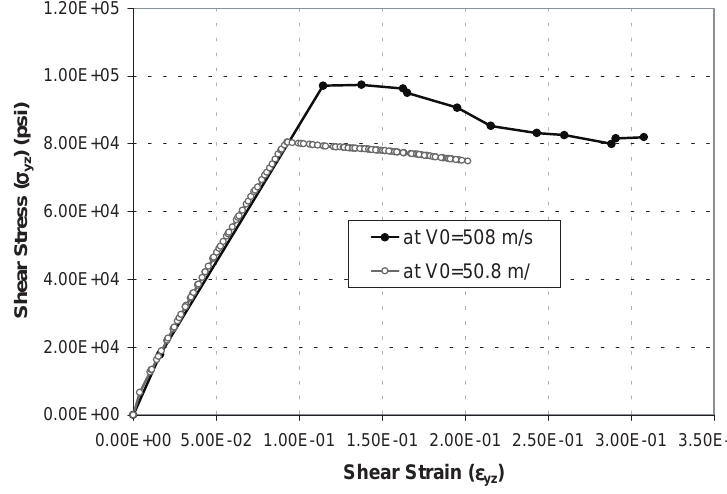
Fig. 12. A comparison of constitutive material response under